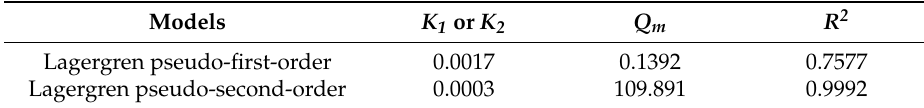
Table 4. Simulation of sorption kinetic equations and corresponding parameters.